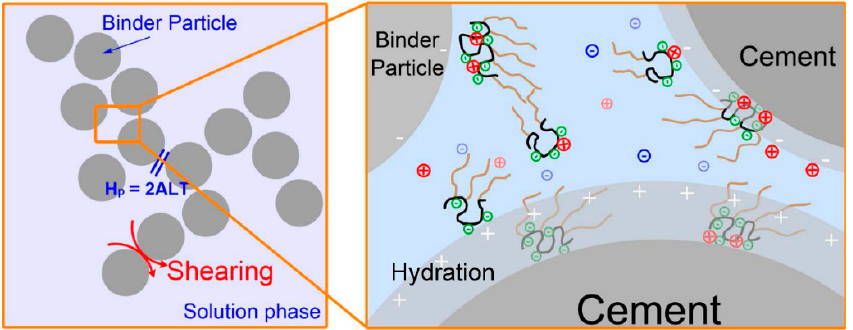
Figure 2. Microscale view of cement paste and different forms of PCE molecules in cement paste.